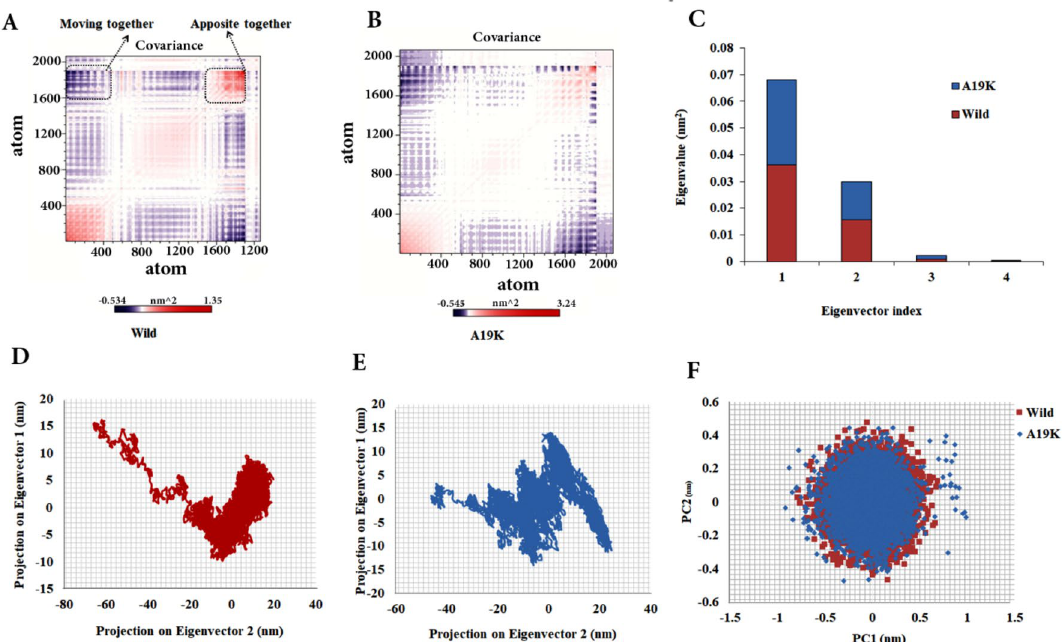
Figure 4. Dynamic effects of the WT and p.A19K variant in the Brazzein /hTLR5 complex. ( A , B ) Covariances between WT and mutant residues in complex with hTLR5. ( C ) Bar plot of the eigenvector index versus eigenvalues for the first four eigenvectors of two protein–protein complexes. ( D , E ) Cross correlation matrix C-alpha atomic graph and plot in during 100 ns simulation for the wild and the mutant systems. ( F ) PCA scatter plots for the first and second principal components (PC1 and PC2) for WT and p.A19K variant, showing differences between the eigenvectors of the two